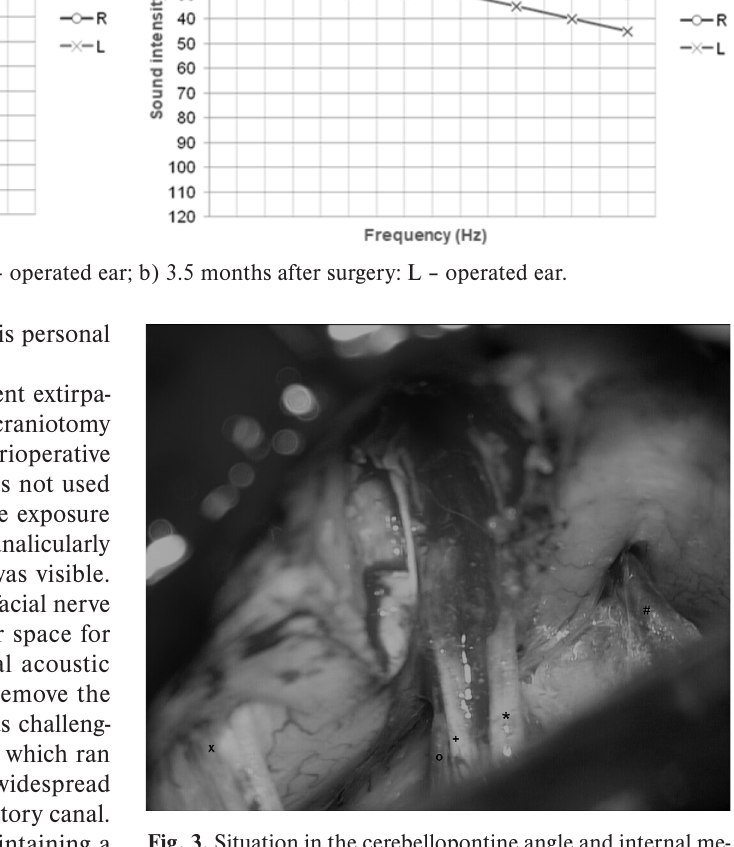
Fig. 3. Situation in the cerebellopontine angle and internal me-